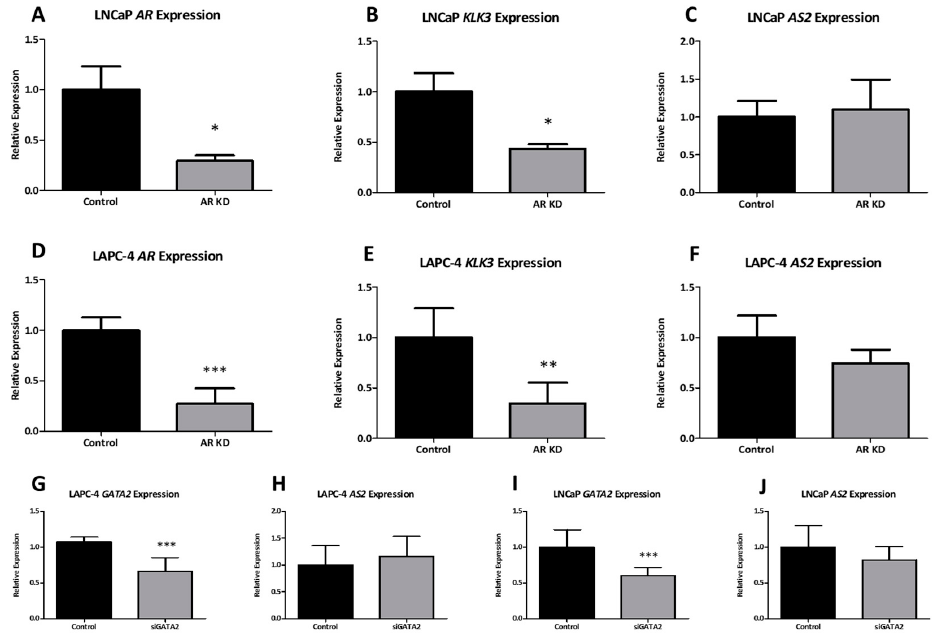
Figure 5. The expression of AR , KLK3, and AS2 was measured via qPCR in LNCaP and LAPC-4 cells n ≥ 3. Pairwise means comparison was done using a T -test, *: p < 0.05, **: p < 0.01, ***: p <